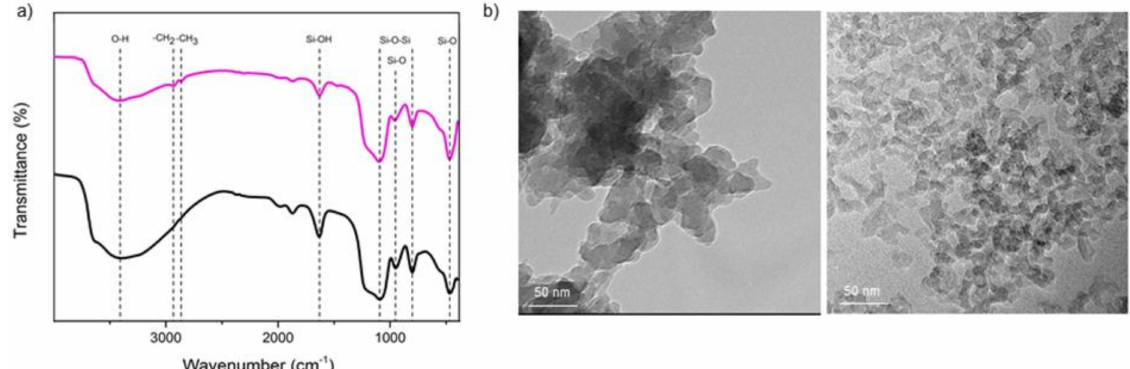
Figure 1. ( a ) Fourier Infrared (FTIR) spectra of silica nanoparticles (SNP) (black) and SNP-RB (pink) in transmittance mode; and ( b ) Representatives of Transmission Electron Microscopy (TEM) micrographs of the SNP (right) and SNP-RB (left) in 50 nm